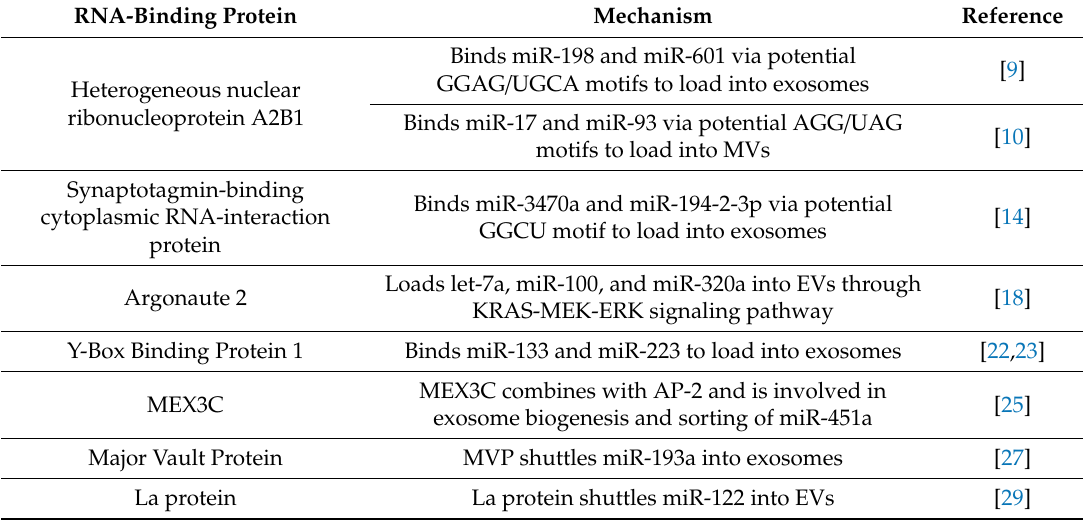
Table 1. List of miRNA sorting mechanisms regulated by RNA-binding proteins. RNA-Binding